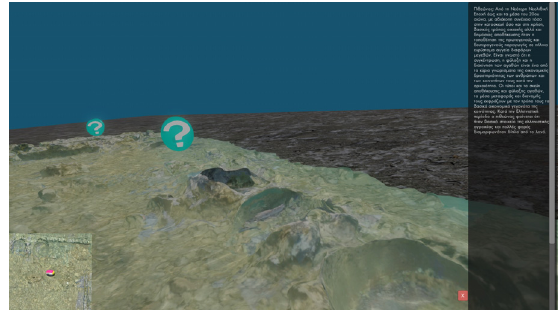
Figure 10: The environment of the virtual tour application.